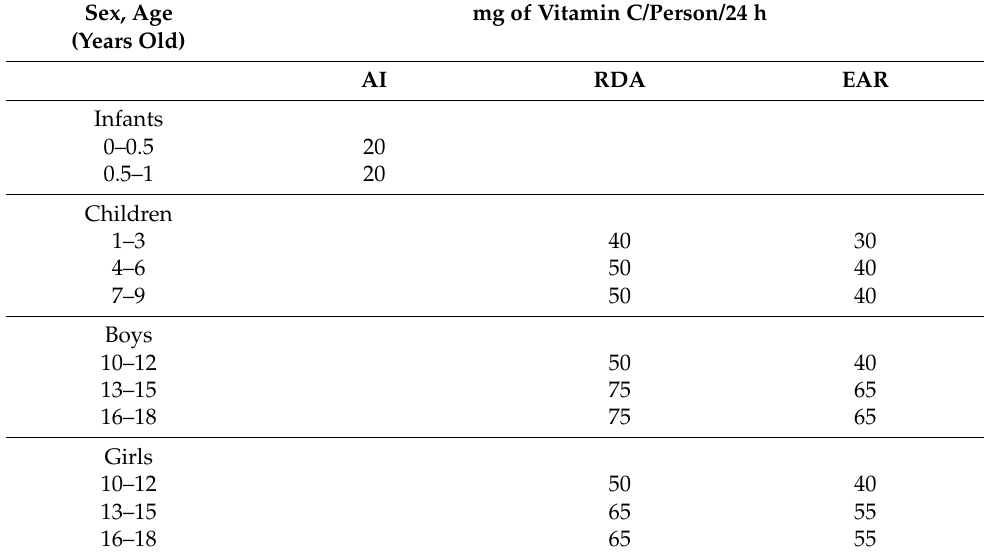
Table A4. Vitamin C—recommended dietary allowance (RDA); estimated average requirement (EAR), and adequate intake (AI) for Polish healthy